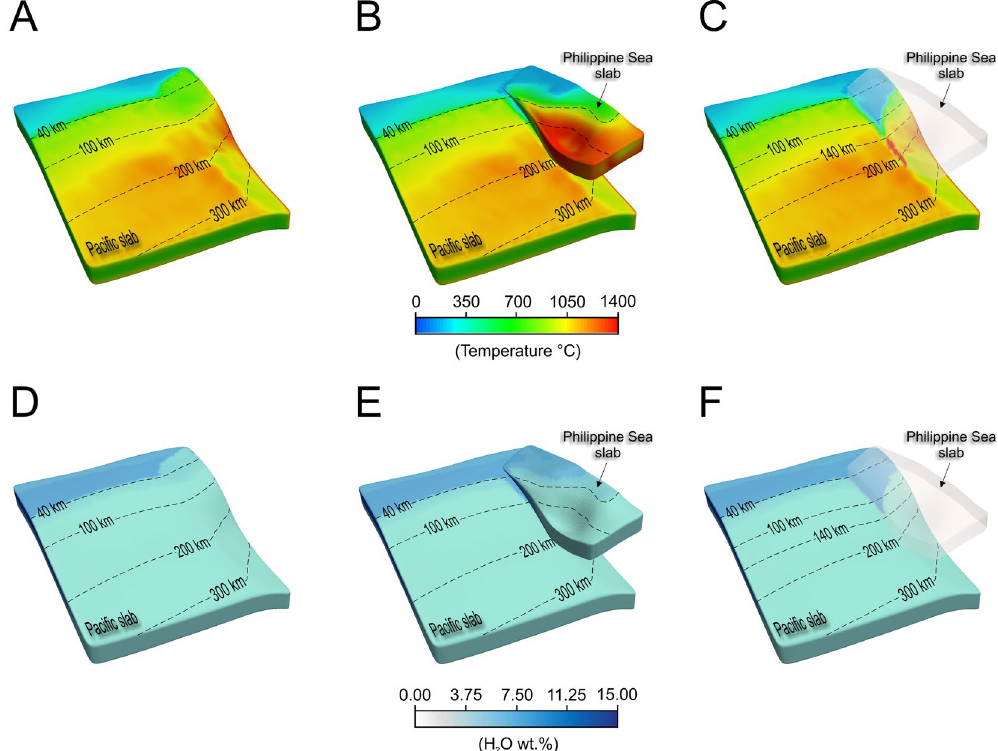
Figure 2. Slab temperature and H 2 O distribution. ( A,D ) Numerical experiment with a single plate (Pacific). ( B,C,E,F ) Numerical experiment with double subduction. In ( C ) and ( F ), the Philippine Sea plate is shown as a semitransparent surface. Note that the water content in ( D , E , F ) reflects complete slab hydration, whereas in nature slabs are assumed to be partial hydrated 46 . Therefore our estimates should be considered as an upper